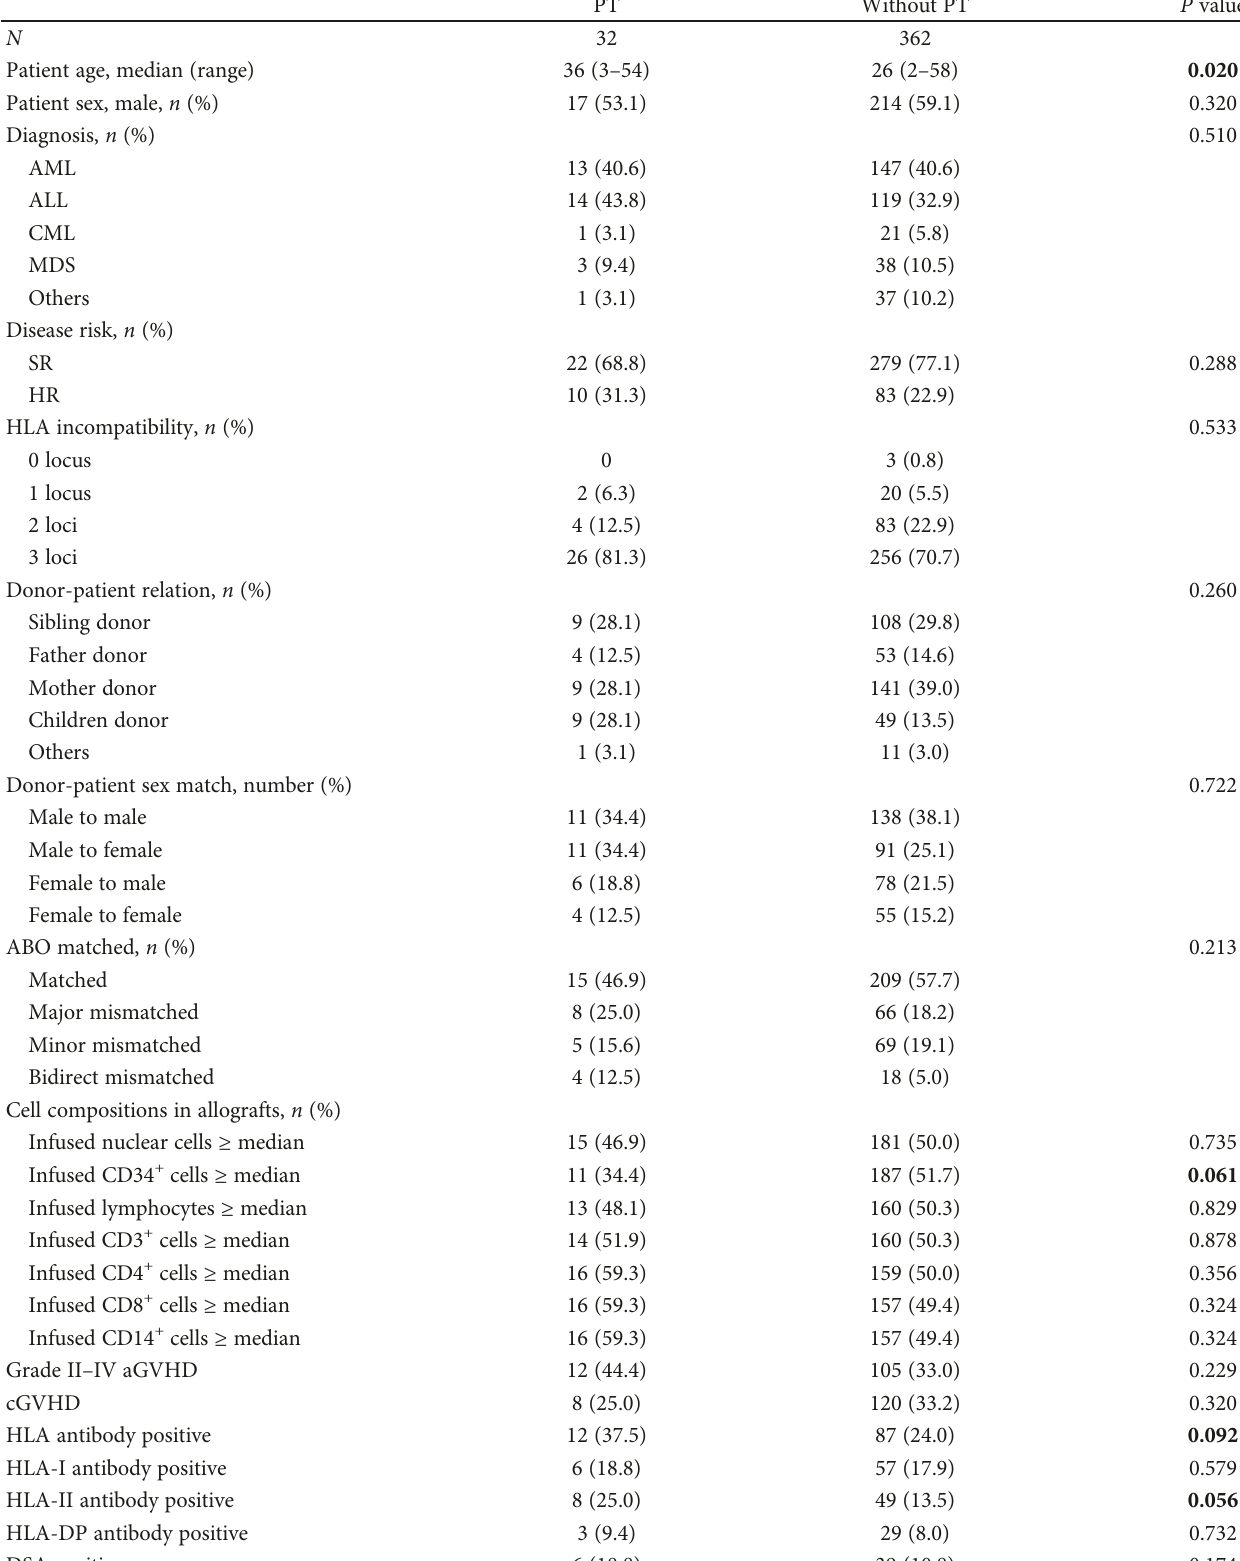
Table 3: Patient characteristics in groups with and without